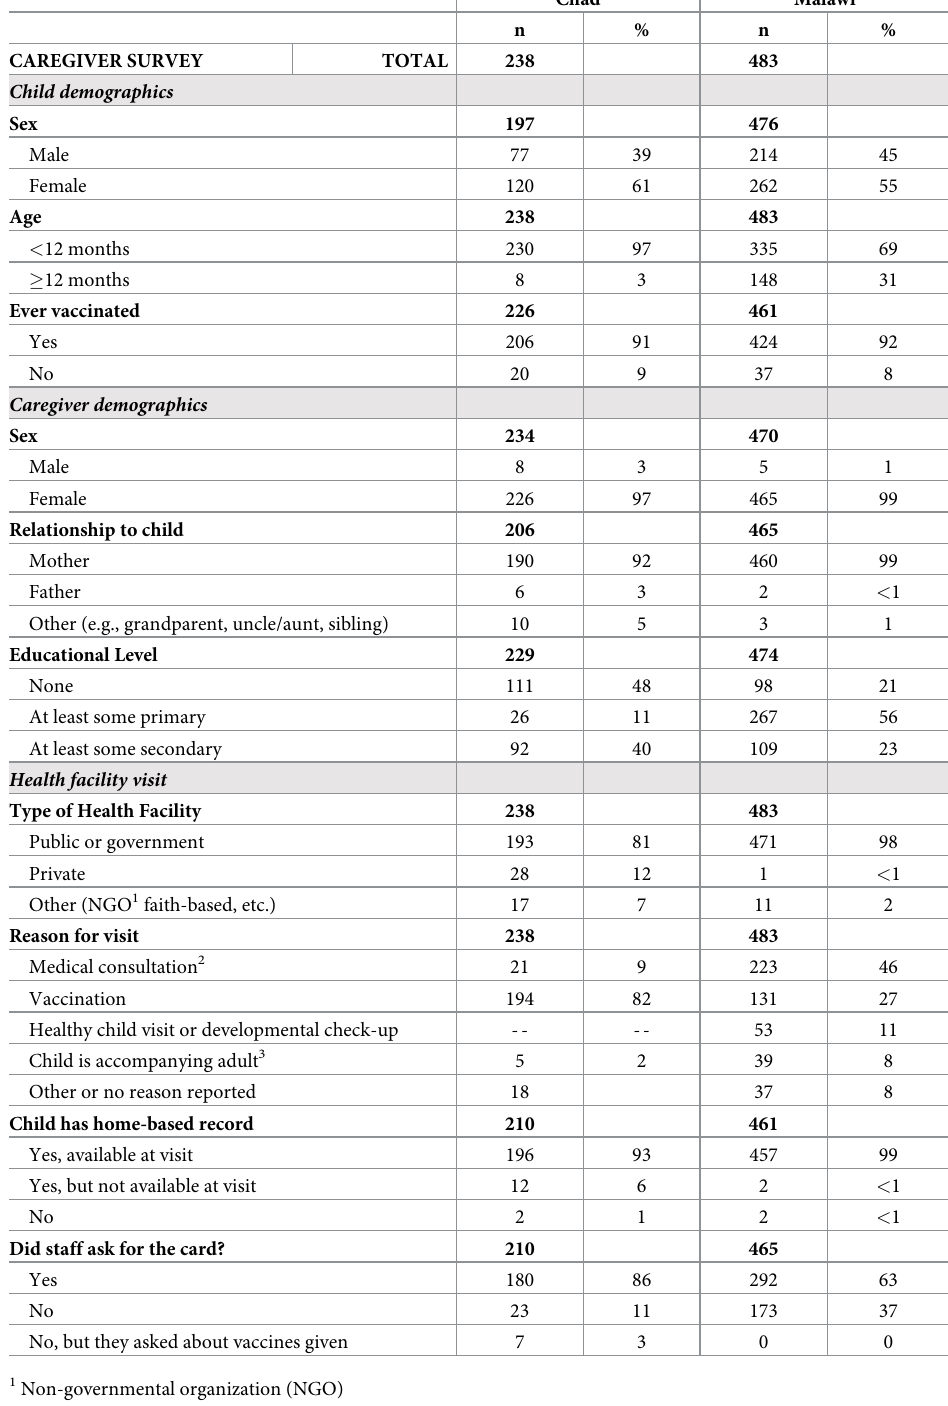
Table 1. Characteristics of surveyed caregivers of children with documented vaccination dates: Chad and Malawi,